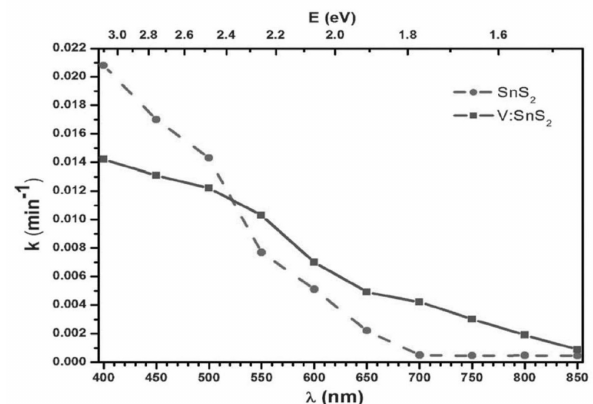
Figure 11. Shift to longer wavelengths of the SnS 2 photocatalytic response when part of the Sn cations are substituted by V cations (Reproduced from Ref.